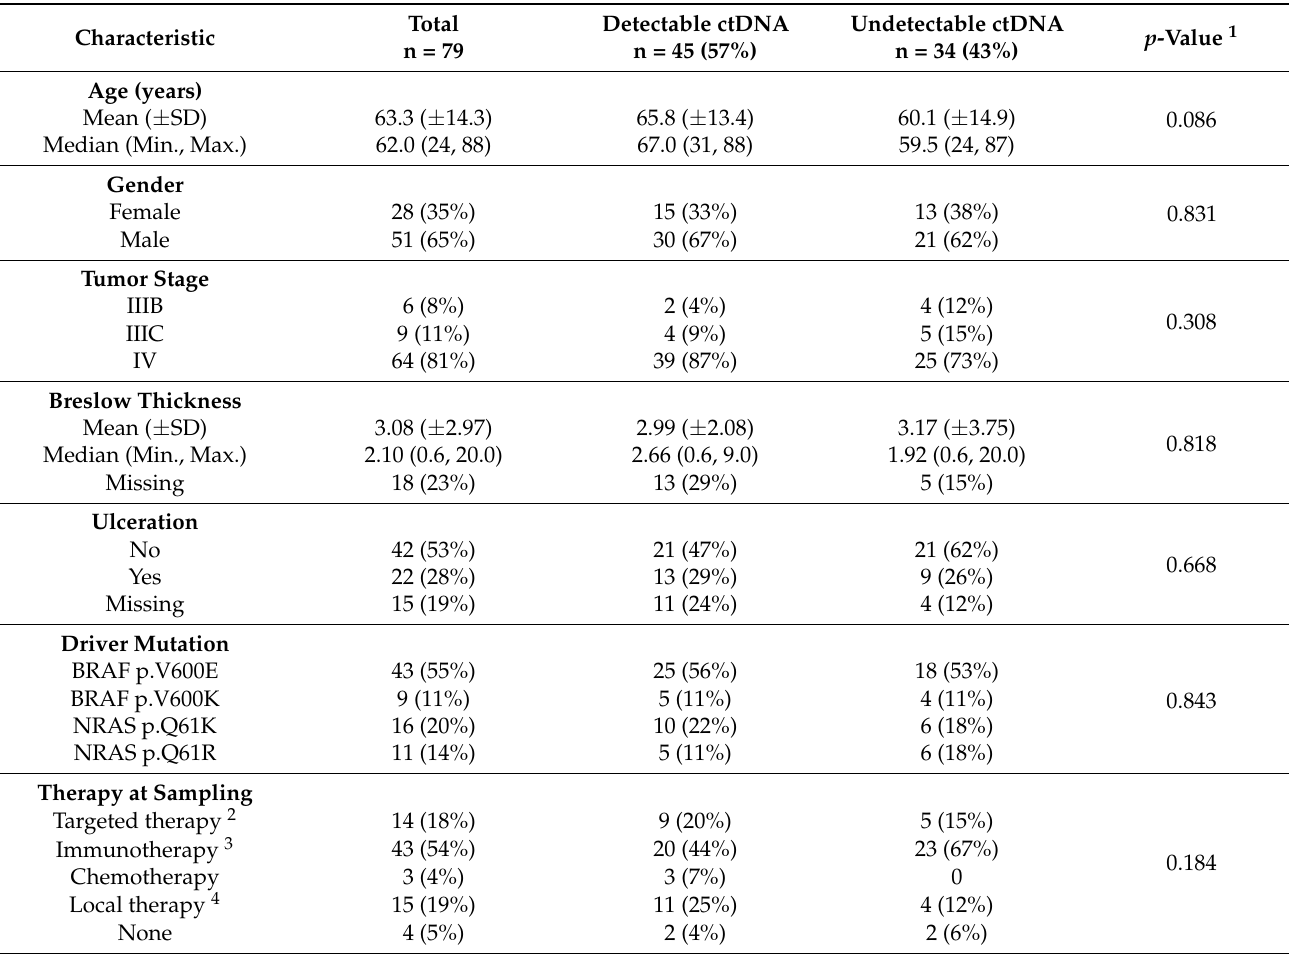
Table 1. Patients’ characteristics in the overall population, in patients with detectable ctDNA and undetectable